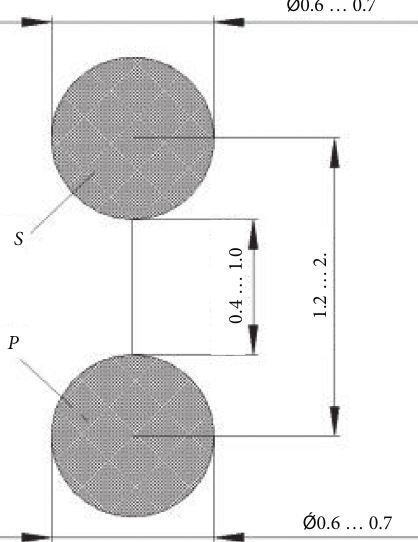
Figure 7: Geometrical parameters of the two-element photode- tector to detect the ( o ) ( S ) and ( e ) ( P ) light component.